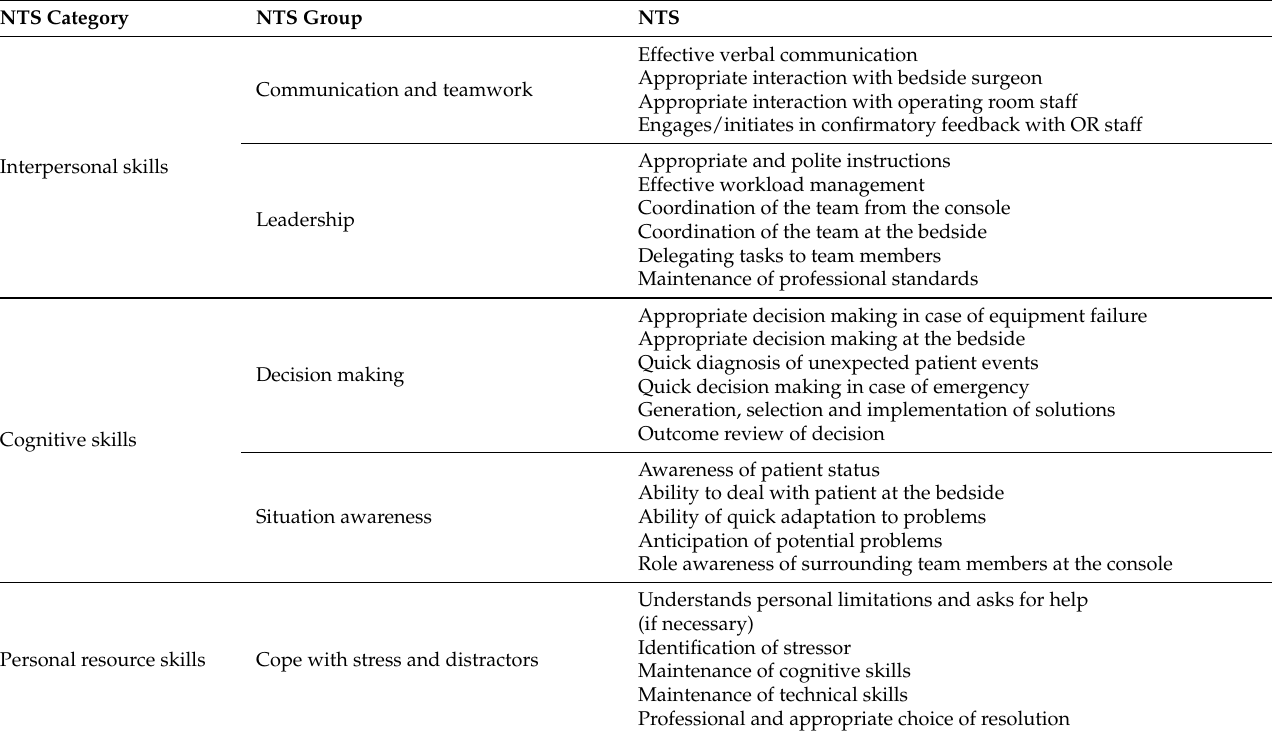
Table 4. Interpersonal and Cognitive Assessment for Robotic Surgery (ICARS) expert rating metrics [22]. NTS